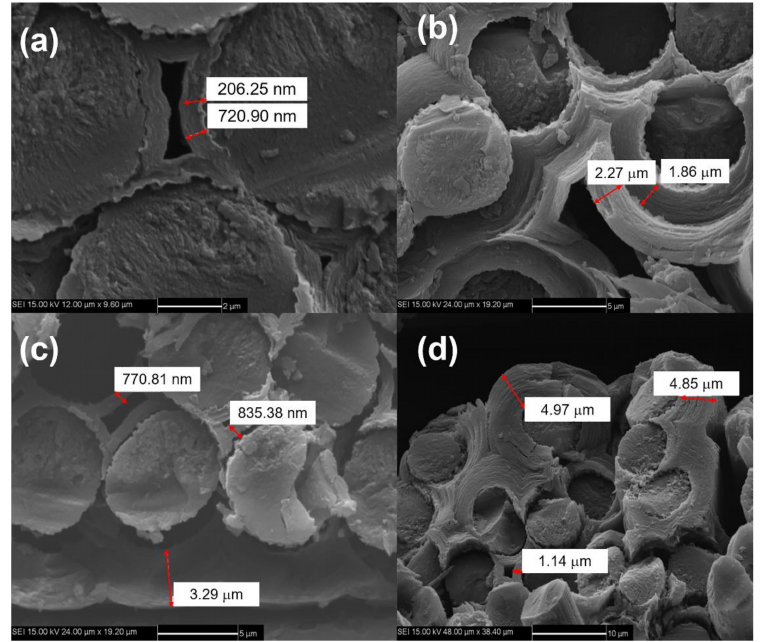
Figure 2. ( a ) First chemical vapor deposition (CVD) carbon matrix; ( b ) second CVD carbon matrix; ( c ) multiple CVD carbon matrix; and ( d ) multiple CVD carbon